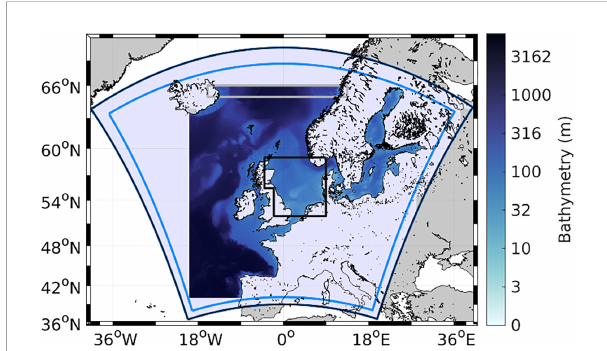
FIGURE 2 Bathymetry of the wave model WAM (shaded) and domain of the CCLM regional climate model (dark blue box). The area between the dark and light blue boxes is regarded as the buffer zone and is neglected in the analysis. The black box indicates the area of the North Sea. The grey box indicates the area, which is part of the WAM bathymetry but not the NEMO